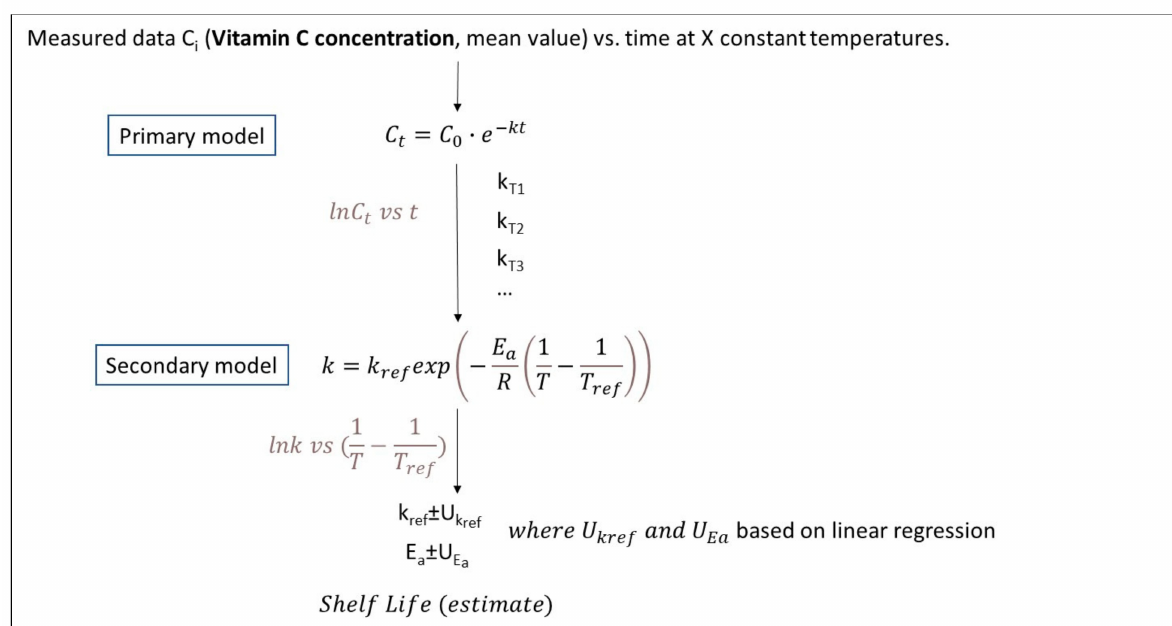
Figure 4. Indicative workflow of the conventional two-step approach (frequentist approach) using an example of the Vitamin C loss during frozen storage for vegetables, providing a mean value for the prediction of the shelf